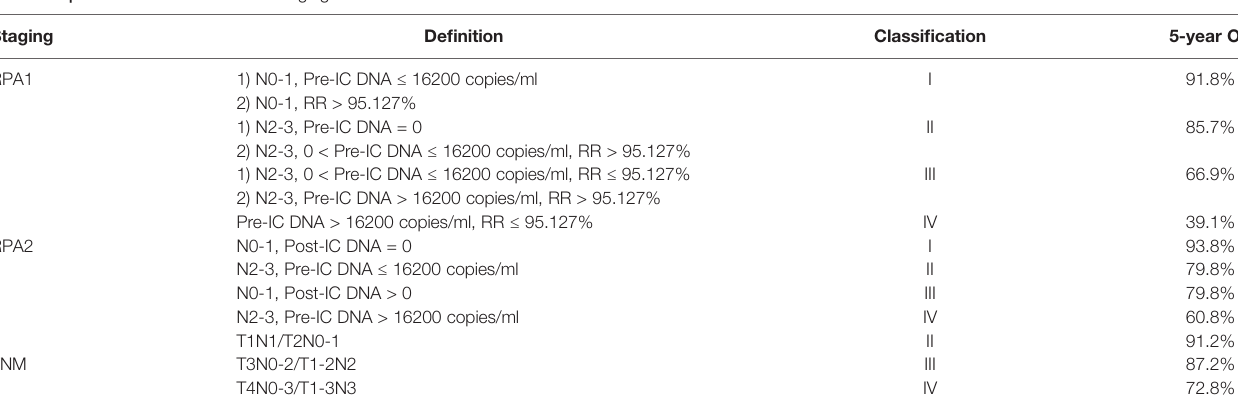
TABLE 1 | De fi nition of different RPA staging.